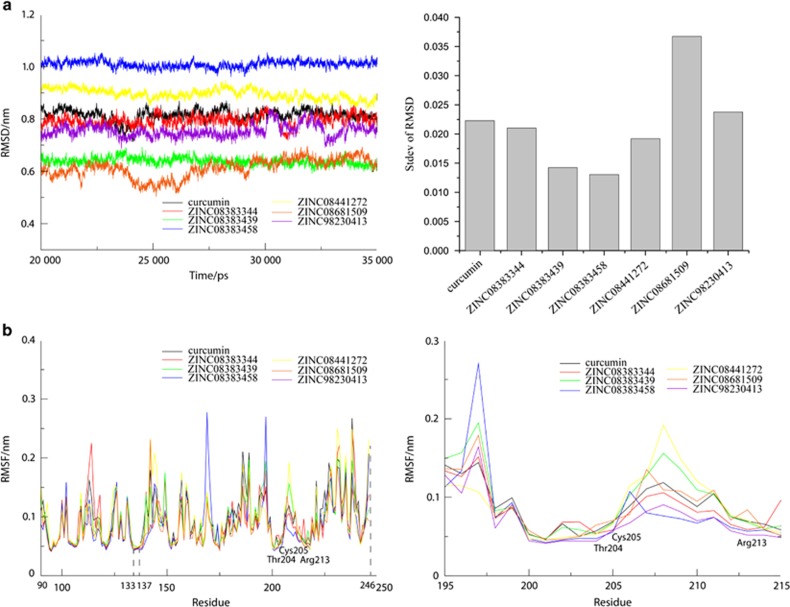
RMSD and RMSF analyses of seven SrtA-ligand complexes. (a) The backbone and standard deviation of RMSD for SrtA-ligand complexes during 20 to 35 ns MD trajectories. (b) Comparison of the backbone RMSF for each SrtA-ligand system during each stable MD trajectory and the crucial residue at the active site. MD, molecular dynamics; RMSD, root mean square deviation; RMSF, root mean square; SrtA, Sortase A.